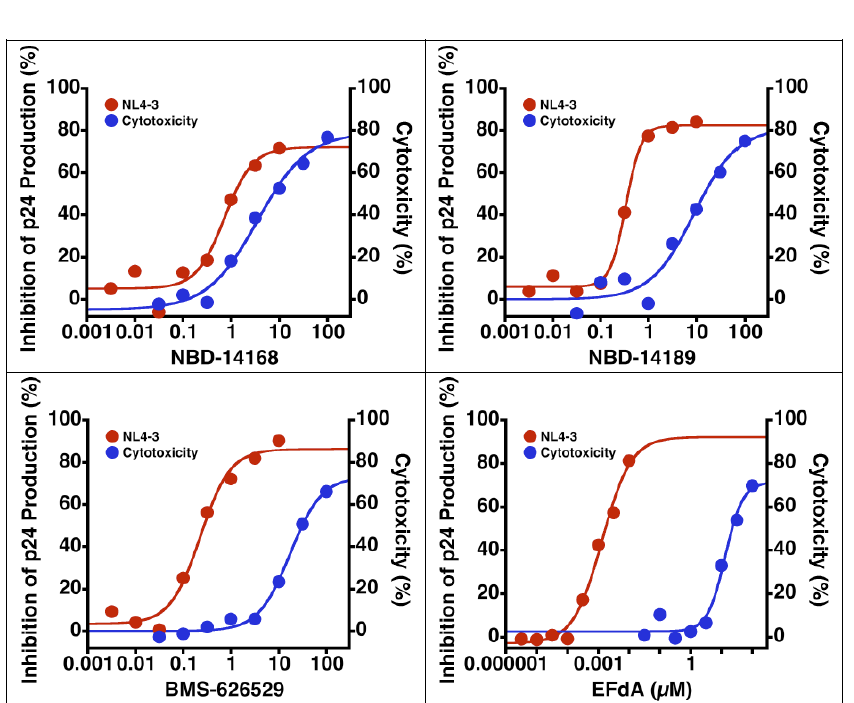
Figure 4. Dose – response plots of in vitro antiviral efficacy and cytotoxicity in PHA-stimulated human PBMCs.